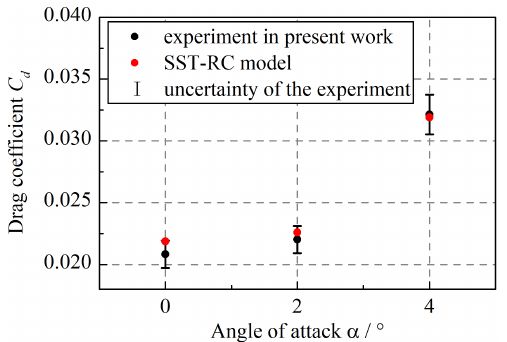
Figure 19. Comparison work of the drag coefficient obtained by numerical simulations and that of experimental investigations.